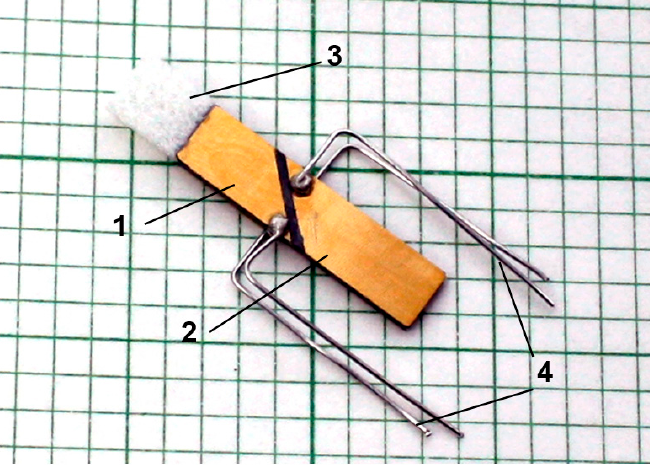
Figure 12. The PMN-32%PT crystal receiver element (case B 2 , 45° gap) with non-rectangular top (1) and bottom (2) electrodes, λ /4 length matching strip of the AIREX T10 110 (3) and electrical wiring (4).